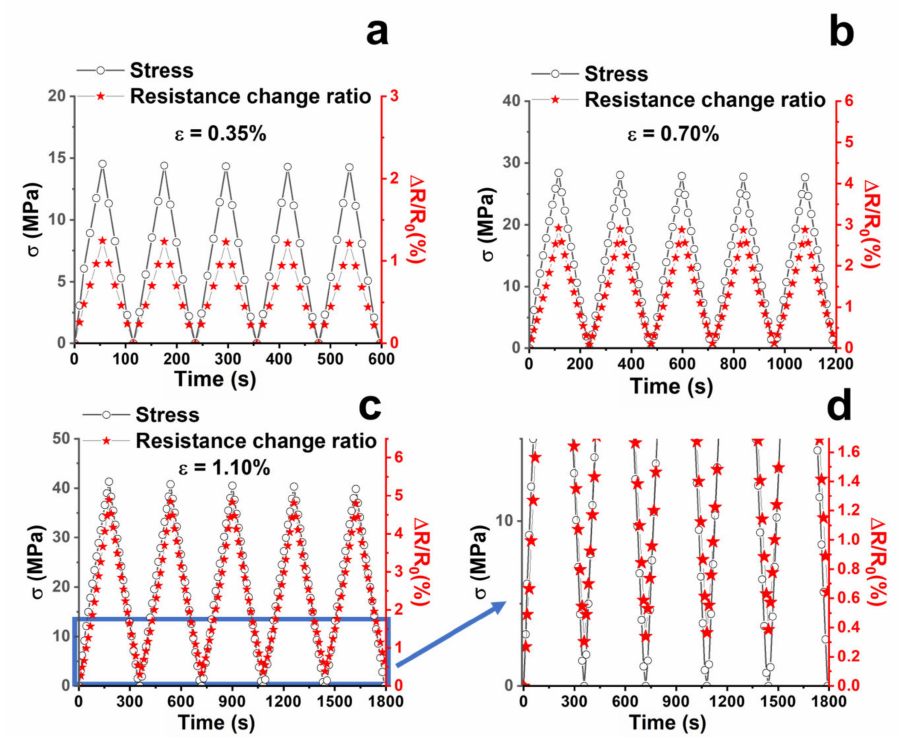
Figure 7. Mechanical stress ( σ ) and percentage resistance variation ( ∆ R/R 0 ) over time when the applied strain is ( a ) ε = 0.35%; ( b ) ε = 0.70%; ( c ) ε = 1.1%; ( d ) enlargement of Figure 7c in the region of start